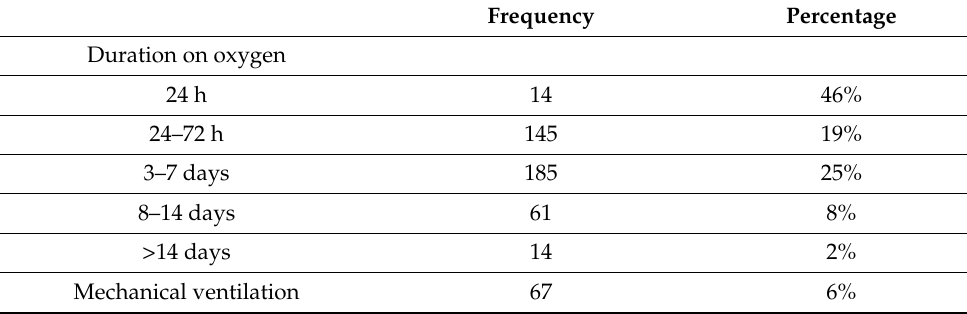
Table 3. COVID-19 patients’ duration on